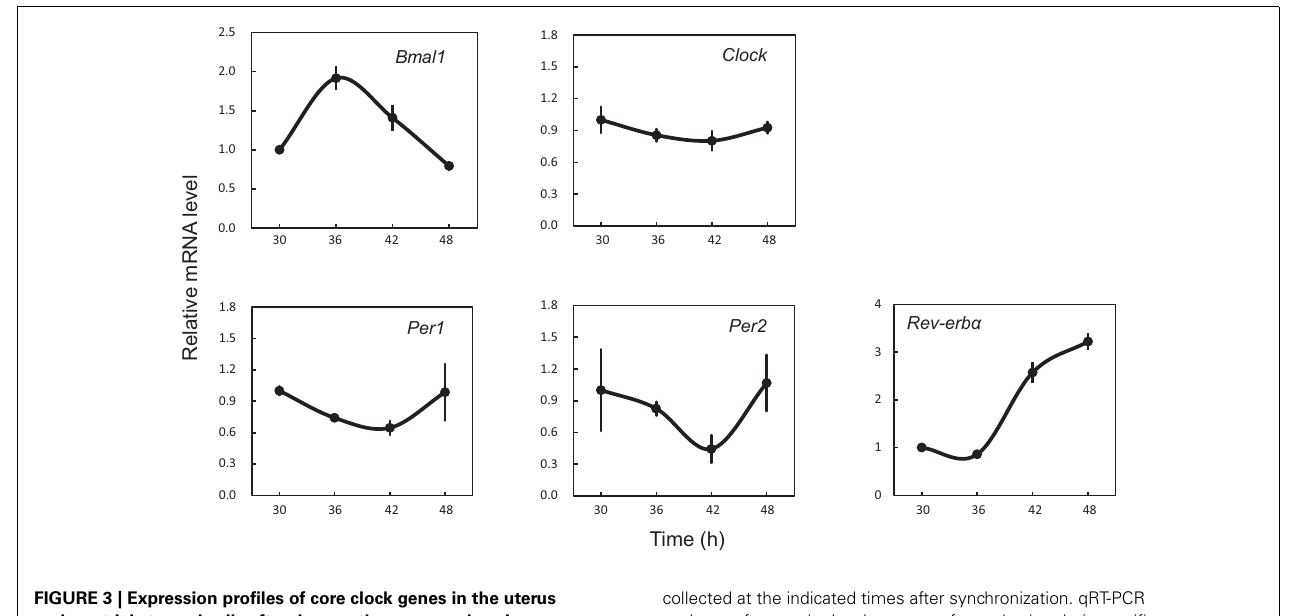
FIGURE 3 | Expression profiles of core clock genes in the uterus endometrial stromal cells after dexamethasone synchroni zation as revealed by RT-qPCR . According to the Per2-dLuc oscillation as illustrated in Figure 1 , total RNA samples were